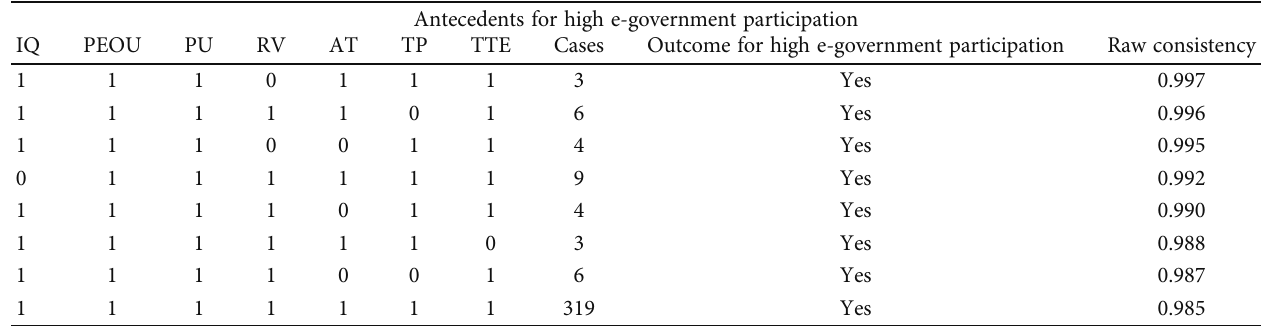
Table 8: Truth table for high e-government participation.